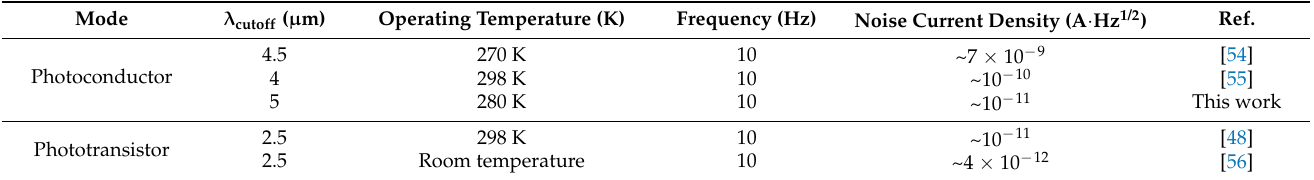
Table 2. Spectra of noise current density of HgTe CQD